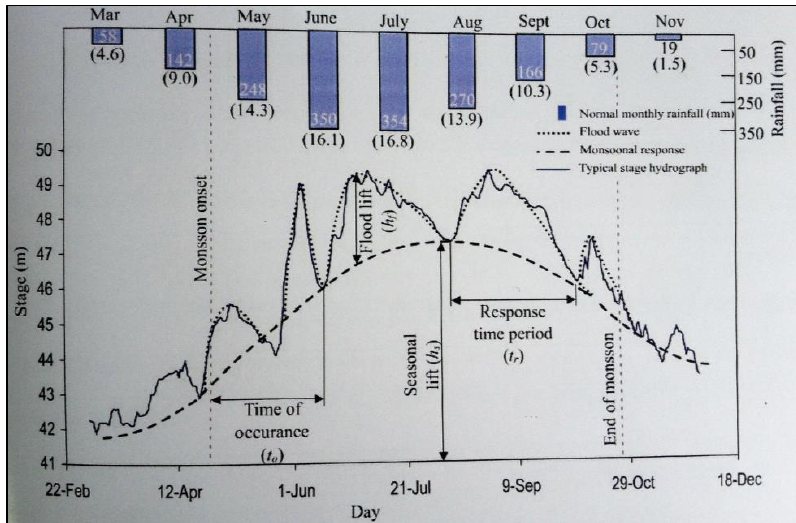
Figure 8. Schematic diagram for approximating stage hydrograph for a river basin. Normal monthly rainfall depth is superimposed on the diagram (the number within the brackets indicates the mean number of monthly rainy days).